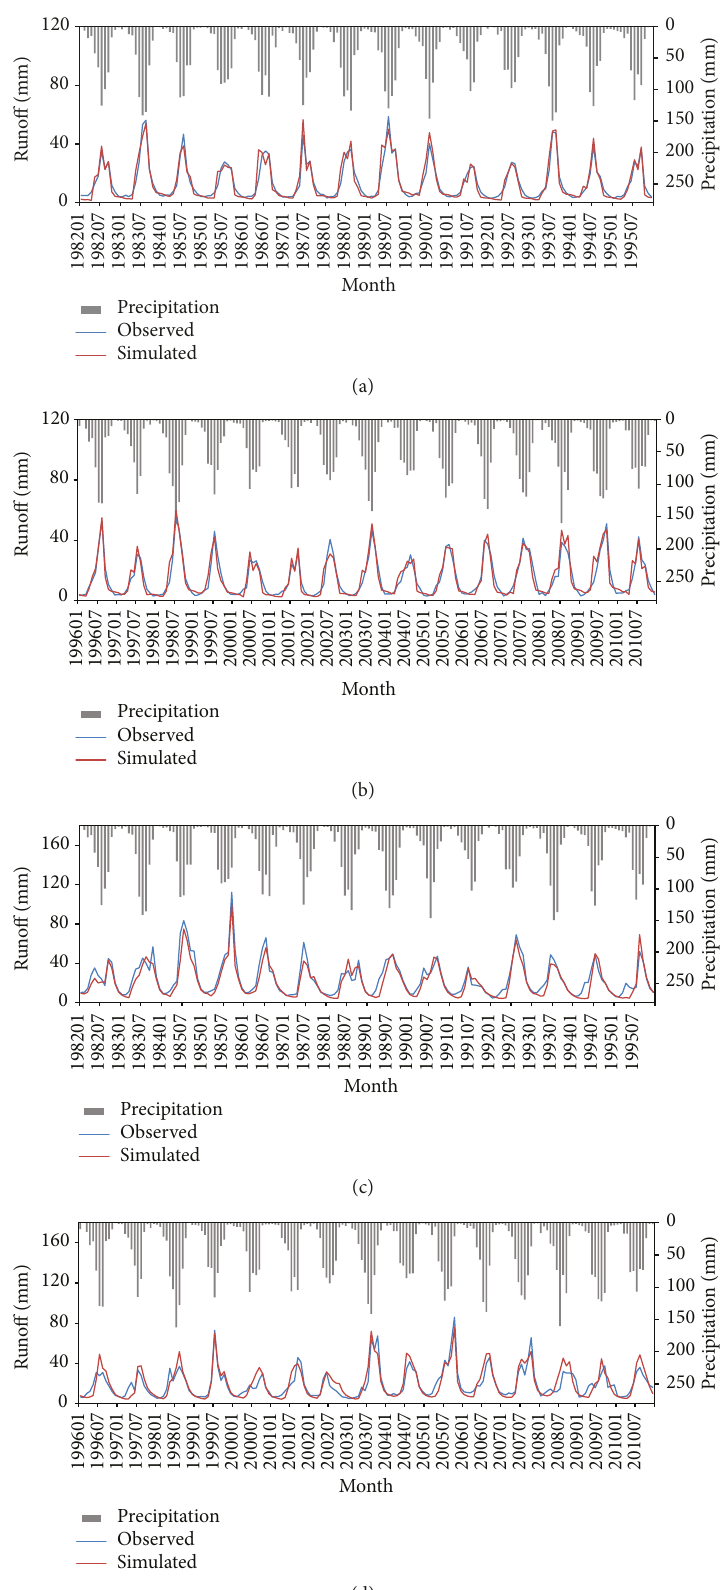
Figure3:SimulatedandobservedmonthlyrunoffvariationinYLCduring(a)calibrationand(b)validationandinMXCduring(c)calibration and (d)